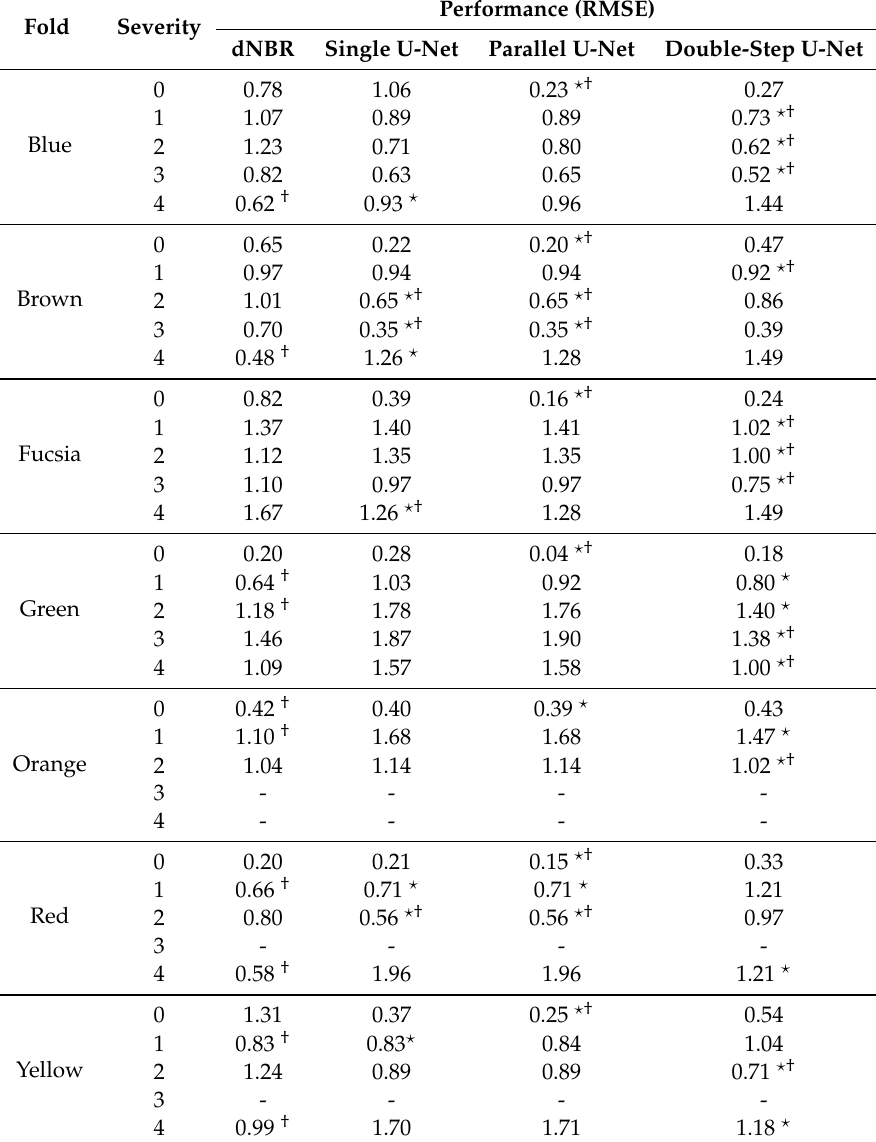
Table 5. Cross-validation performance per fold. ( (cid:63) ) indicates the best RMSE per severity category among the three U-Net versions. ( † ) indicates the best RMSE per severity category, dNBR